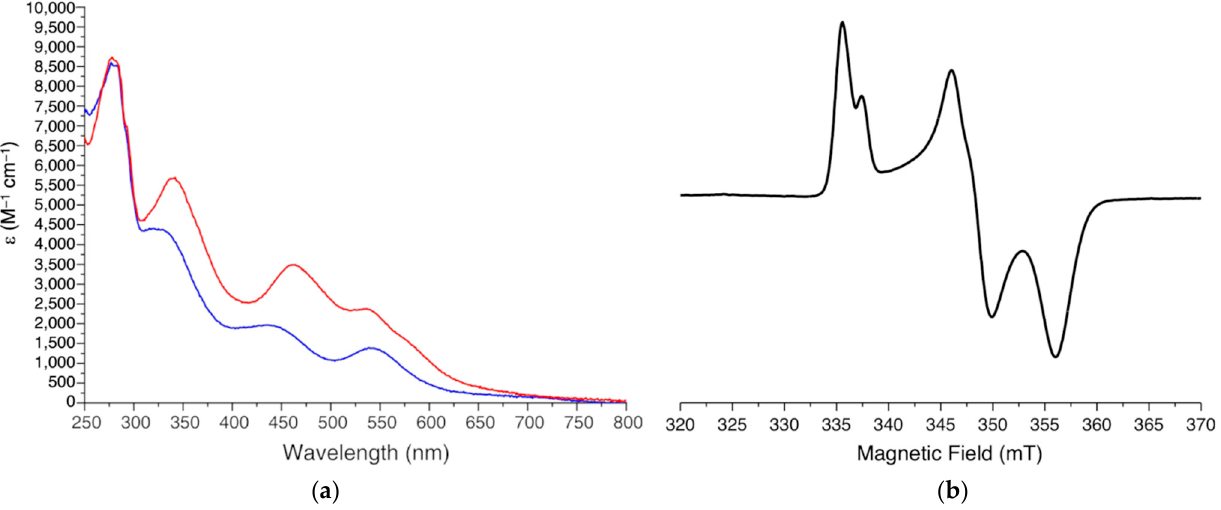
Figure 2. ( a ) UV-Visible spectra of oxidized [2Fe-2S] 2+ mitoNEET (red line) and of dithionite reduced [2Fe-2S] + mitoNEET (blue line). ε values are based on monomeric protein concentration. ( b ) CW X-band EPR spectrum of dithionite reduced [2Fe-2S] + mitoNEET, acquired at 45 K, 1